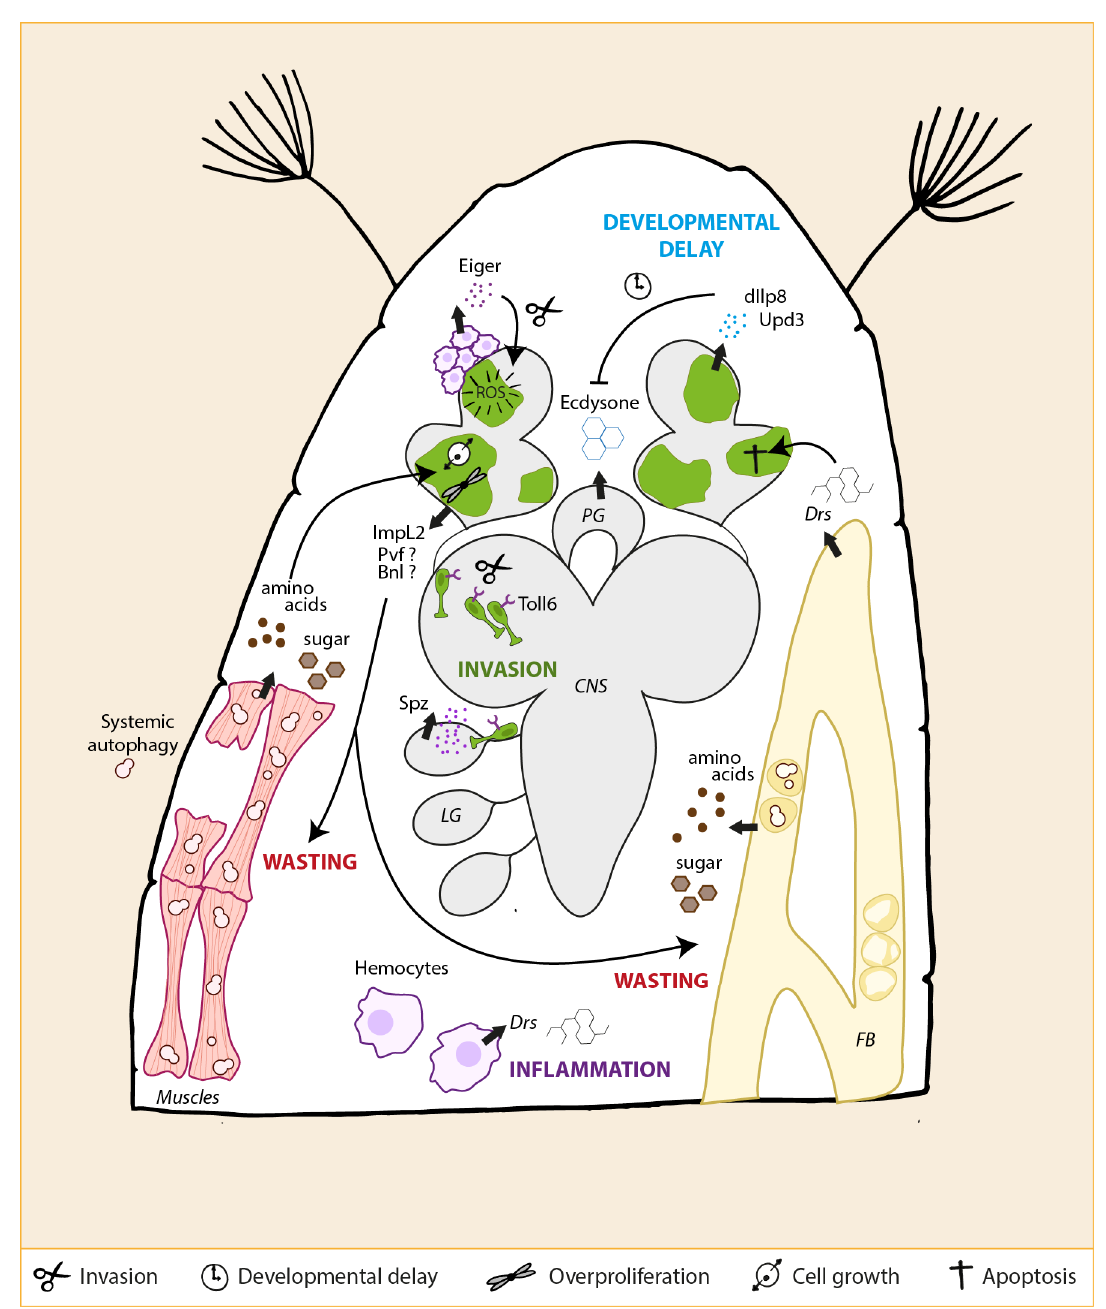
Figure 4. Ras V12 ; scrib − / − eye antennal disc tumors alter distant organ functions. Invasion: Ras V12 ; scrib − / − tumors (green) invade adjacent organs such as the central nervous system (CNS) and the leg discs (LD). Invasion is guided by the interaction between the Toll6 receptor at the surface of invasive tumor cells and its ligand Spz, secreted by a subset of organs prone to secondary tumor formation. Developmental delay: It relies on the decrease of Ecdysone production by the prothoracic gland (PG). The tumor cells secrete Dilp8 and Upd3, which are both known for their ability to inhibit Ecdysone production. Inflammation: Tumor cells (green) have elevated ROS levels, attracting plasmatocytes (purple) to the basement membrane breach. These plasmatocytes secrete Eiger and contribute to mmp1 expression in the tumor cells and subsequently to their ability to escape the primary tumor, arguing for a pro tumorigenic function. Together with the fat body, they constitute the potential source of the AMP Drosomycin that is found elevated in the larval hemolymph. Drosomycin (Drs) triggers cell death in the tumor, arguing for a potential anti-tumorigenic role of the plasmatocytes. Wasting: Tumor cells secrete ImpL2 (and potentially Pvf and Bnl), which is thought to trigger a wasting phenotype in the larva characterized by the morphological deterioration of the energy-storing organs: the muscles (shrinkage and split) and the fat body (pearl-like phenotype, lipid droplet aggregation). This is accompanied by elevation of autophagy in these organs as well as elevated sugar and amino acid levels in the hemolymph. In its late stage, the tumor building blocks derive from host to maintain its growth.